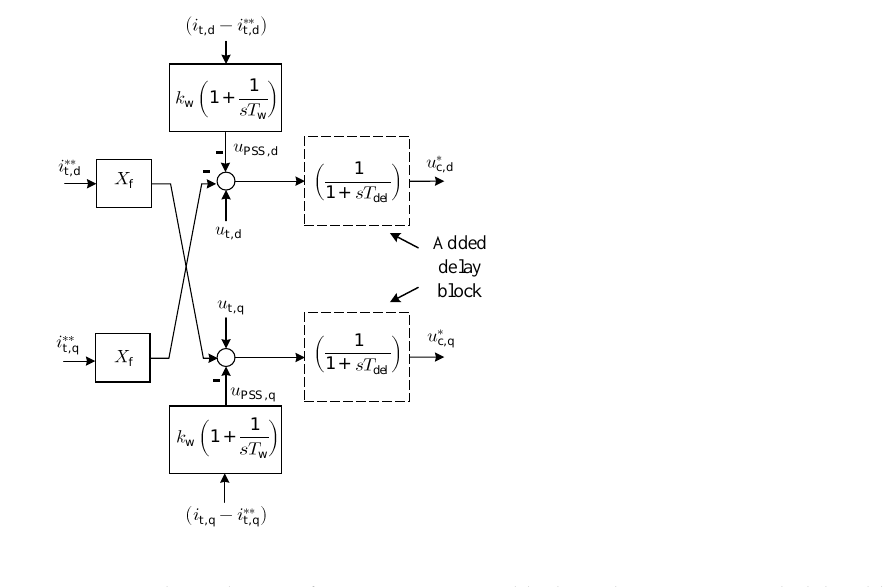
Figure 18. The voltage reference generation block with an intentional delay block in the monolithic simulation.